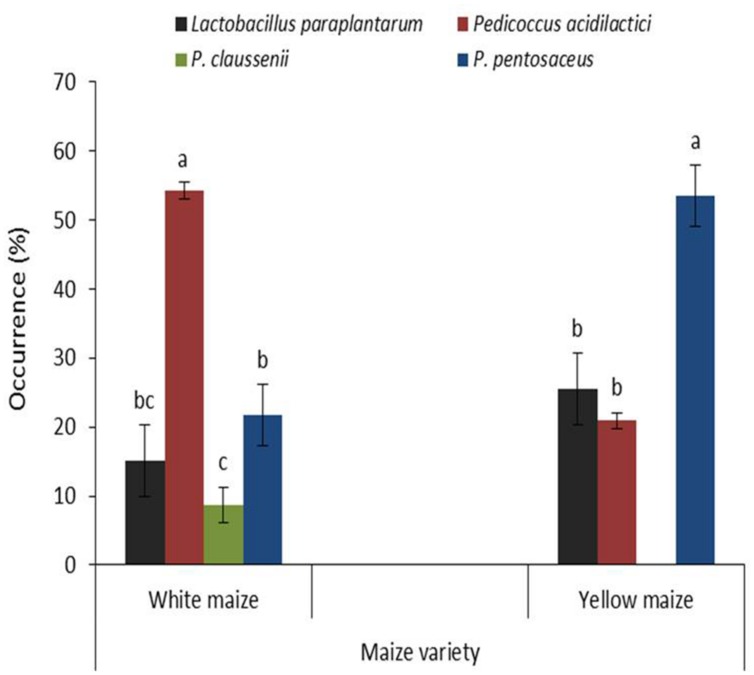
Occurrence of lactic acid bacteria in steep liquor of two varieties of maize grains fermented for 94 h. Vertical lines on bars indicate the standard error of mean (α = 0.05). Bars with different alphabets are significantly different by DMRT at α = 0.05.